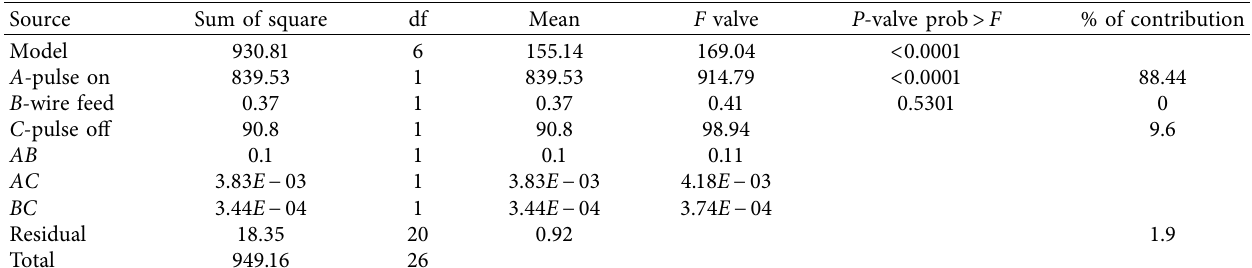
Figure 18: Main effects plot for SN ratios. Table 9: ANOVA for MRR.